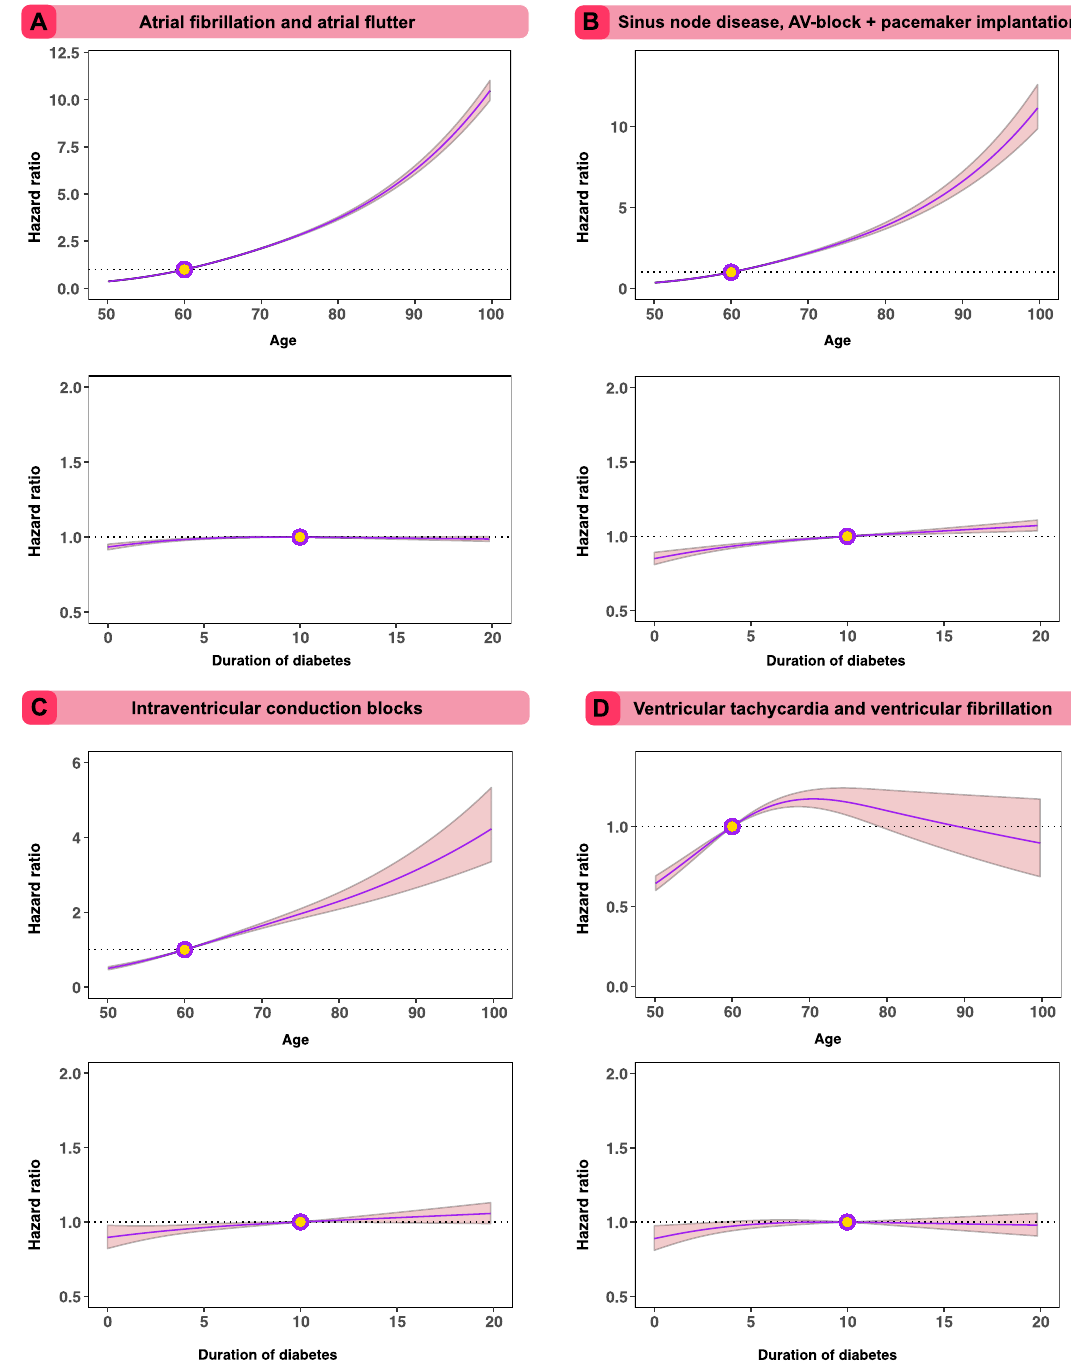
Figure 3. Hazard function for age and duration of diabetes for arrhythmias in patients with type 2 diabetes. Hazard risk for age at baseline and duration of diabetes using restricted cubic splines in an extensively adjusted Cox model. The dark lines indicate the hazard function and the shaded areas 95% confidence